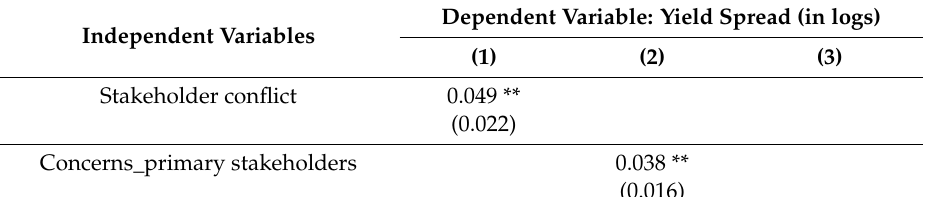
Table 7. Exploring sources of risk exposure in CSR profiles and bond yield